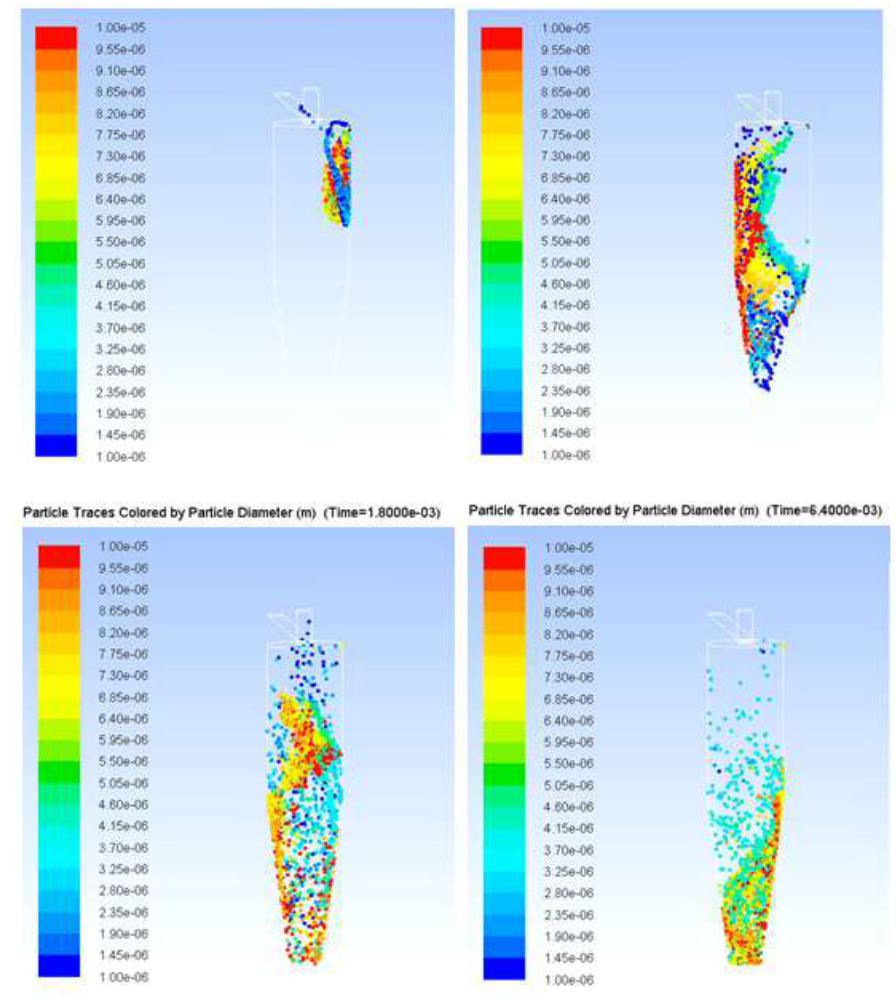
Figure 3. Particle traces colored according to the diameter at varied flow times. The simulation photos have shown the different size particle in the cyclone.